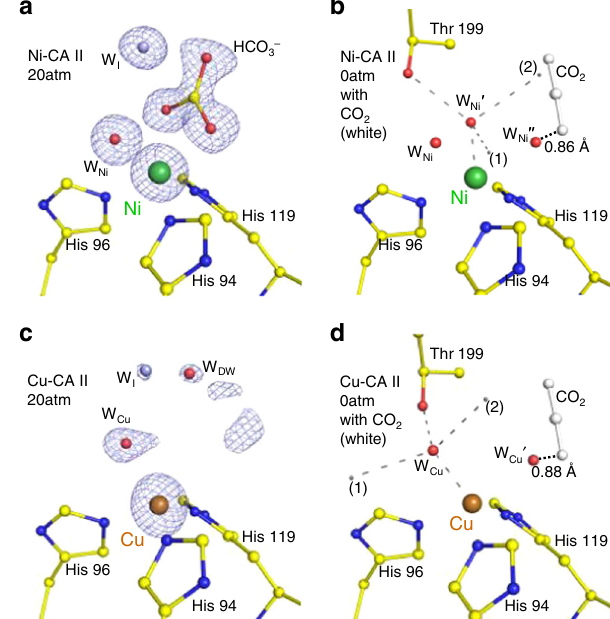
Fig. 4 Substrate/product binding in Co-CA II. The intermediate water (W I ) is colored in steel blue for clarity. The electron density (2F o – F c , blue) and the difference map (F o – F c , green) are contoured at 2.2 σ and 7.0 σ , respectively. a , b At 20 atm of CO 2 pressure, Co-CA II at pH 11.0 shows superposition of CO 2 binding (~50% occupancy, white) with tetrahedral coordination and HCO 3 − binding (~50% occupancy) with octahedral coordination. c , d Co-CA II at pH 7.8 shows complete binding of HCO 3 − , showing octahedral coordination even in absence of added CO 2 . It is likely that the captured HCO 3 − is converted from the CO 2 absorbed in the crystal from ambient air.